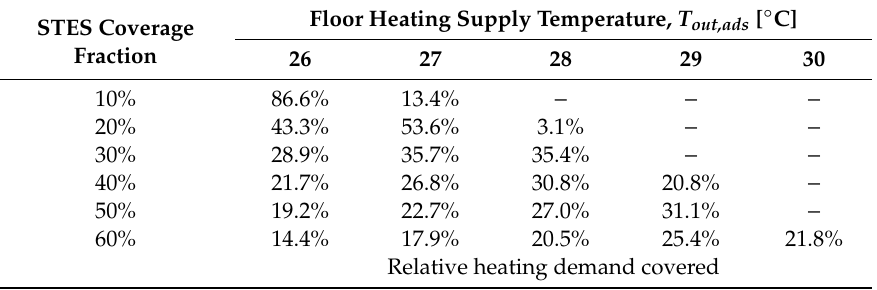
Table 4. Defined space heating supply temperatures for di ff erent solar fraction coverage in Regensburg.